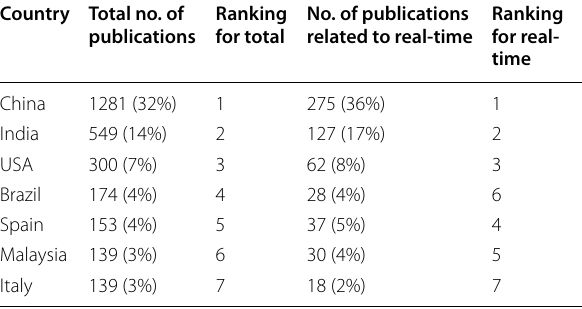
Table 5 Top seven countries according to the total number of publications on the